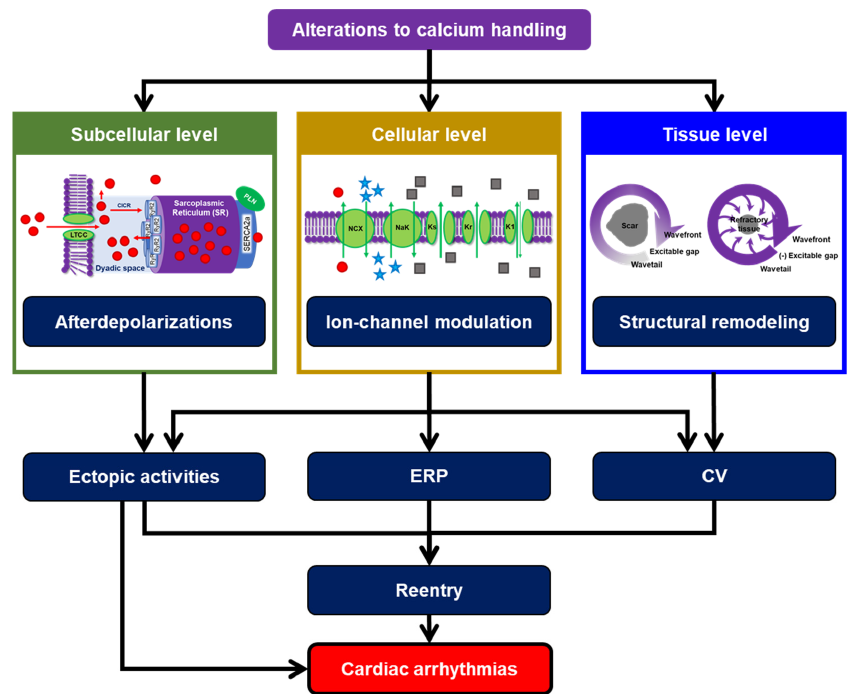
Figure 1. Alterations to calcium handling as a key determinant of cardiac arrhythmias. Subcellular calcium-handling abnormalities may initiate delayed afterdepolarizations (DADs) and triggered activity. At the cellular level, modifications of calcium-handling proteins can directly or indirectly affect cardiac ion-channel function, leading to substantial changes in AP properties. At higher spatial scales, calcium-handling abnormalities may promote structural remodeling, allowing the generation of reentrant waves. Together, those processes may create vulnerable substrates for cardiac arrhythmias. (CICR = calcium-induced calcium release; CV = conduction velocity; ERP = effective refractory period; K1 = inward-rectifier potassium channel; Kr = rapid delayed-rectifier potassium channel; Ks = slow delayed-rectifier potassium channel; LTCC = L-type calcium channel; NCX = sodium-calcium exchanger; NKA = sodium-potassium adenosine triphosphatase; PLN = phospholamban; RyR2 = ryanodine receptor type 2; SERCA2a = sarco/endoplasmic reticulum calcium adenosine triphosphatase-2a).